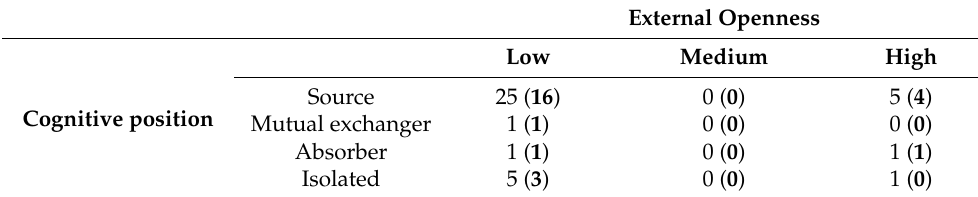
Table 6. Cognitive roles: managerial knowledge exchange 1